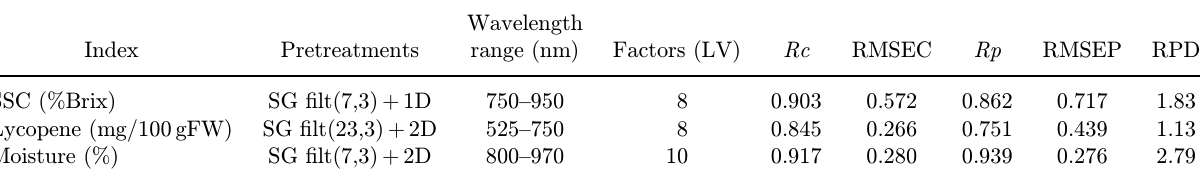
Table 4. Results of NIR calibration and validation performance for nondestructive quality assessment of